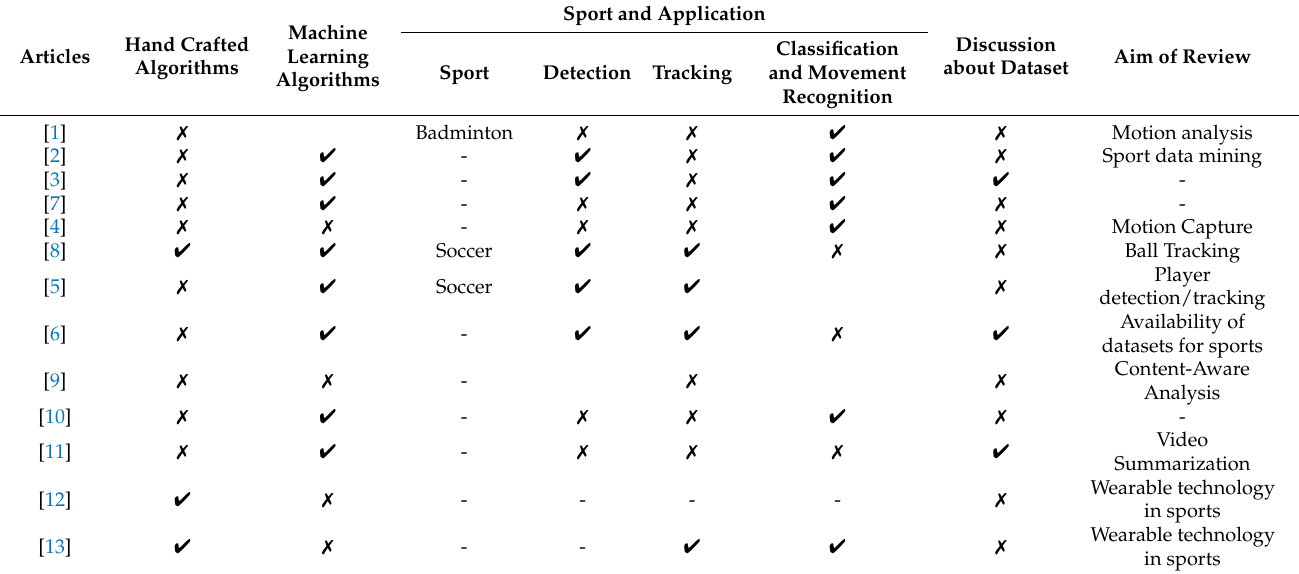
Table 1. Summary of previous surveys and reviews in different